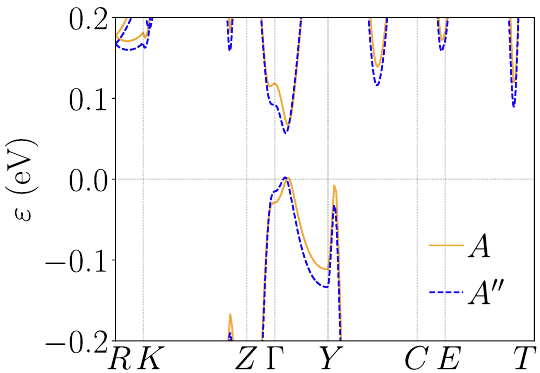
Figure 6: Band structures obtained for models A and A ′′ . The latter correspond to a structural with internal coordinates as model A but lattice parameters a , b and c as in model B